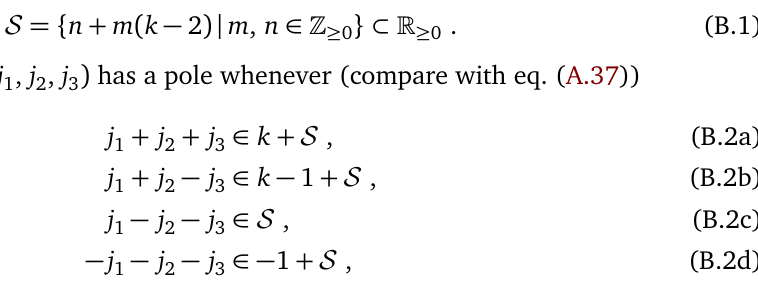
Figure 2: For generic values of the spins j be deformed to avoid poles (left figure). For some special values of the spins j the integration contour in eq. (A.5) gets pinched (right figure) and the four-point function develops a